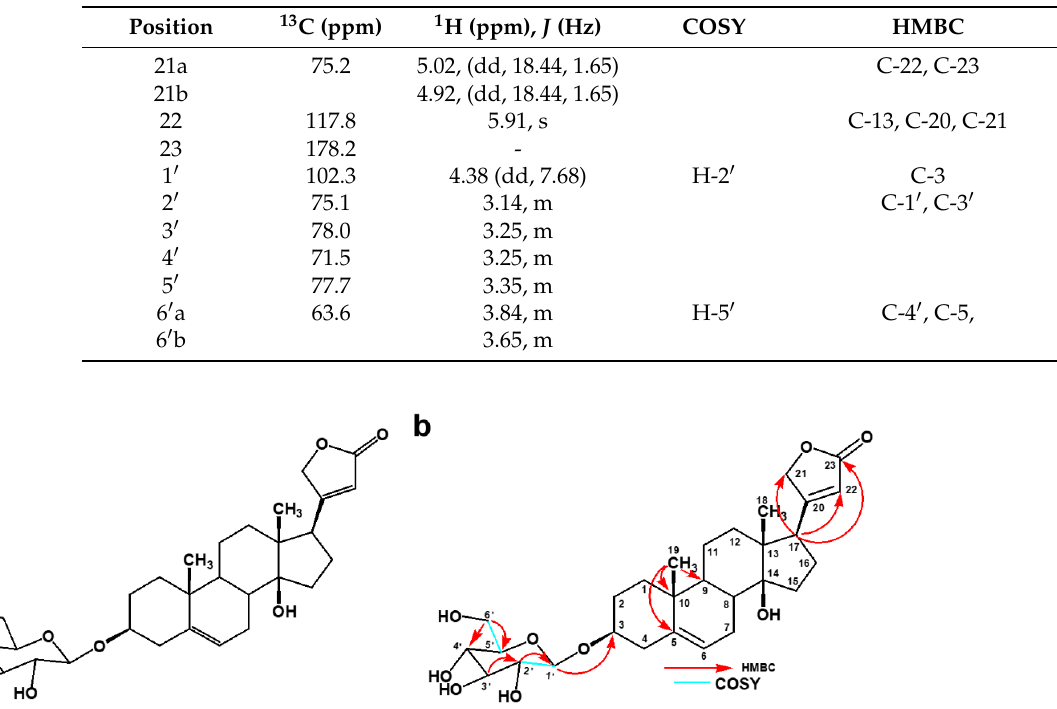
Figure 3. Cardenolide glycoside isolated from X. undulatum , ( a ) xysmalogenin-3, β - D -glucopyranoside ( 2 ), and ( b ) its key HMBC and COSY correlations.